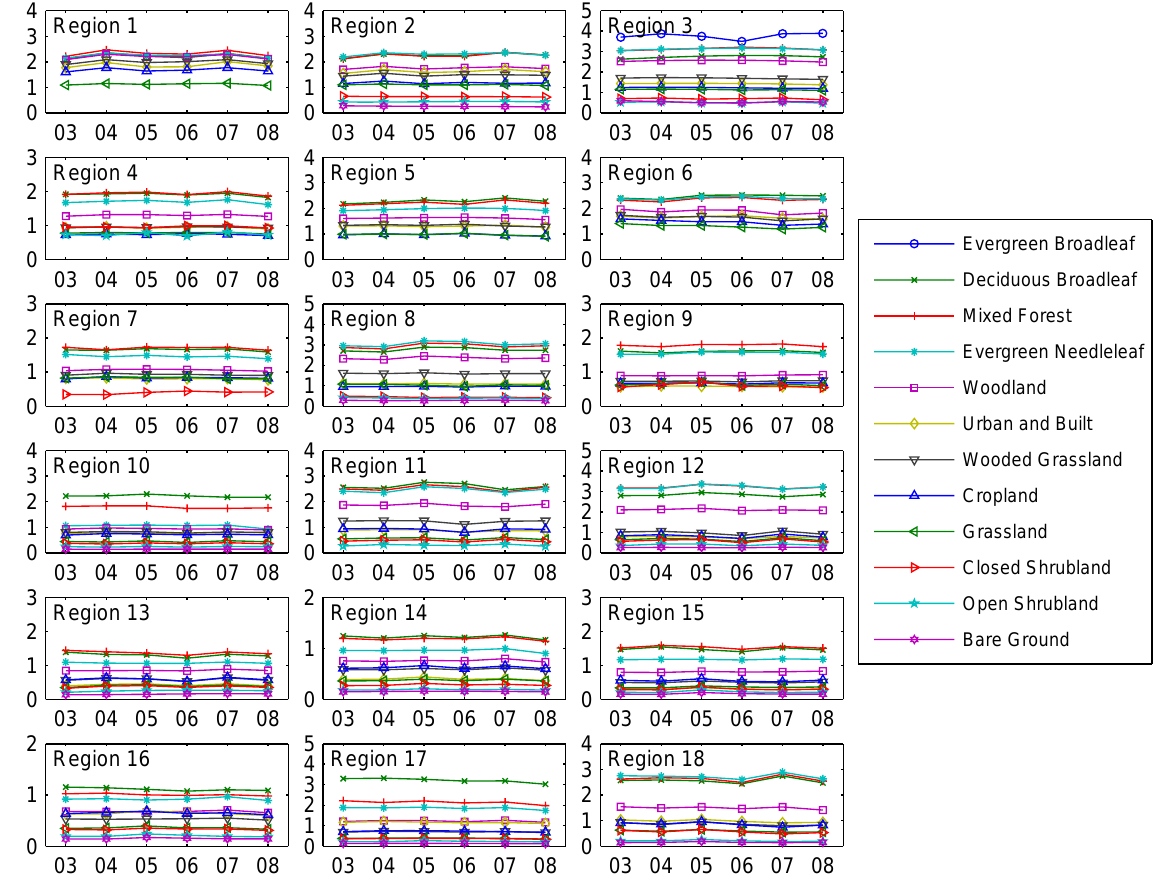
Fig. 7. Summary of MODIS leaf area index (m 2 m − 2 , y axis) from 2003 to 2008 ( x axis) by the UMD land cover classification for each US hydrologic